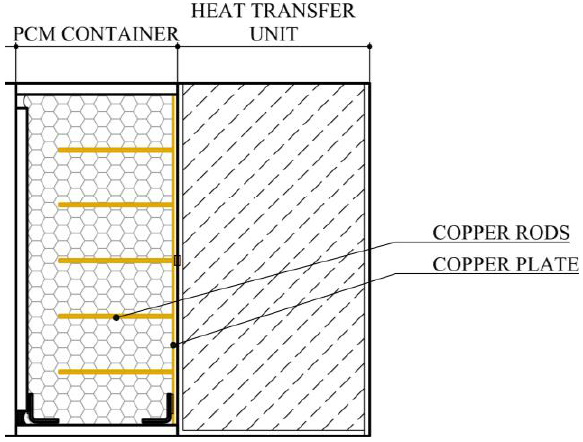
Fig. 1. Module scheme.